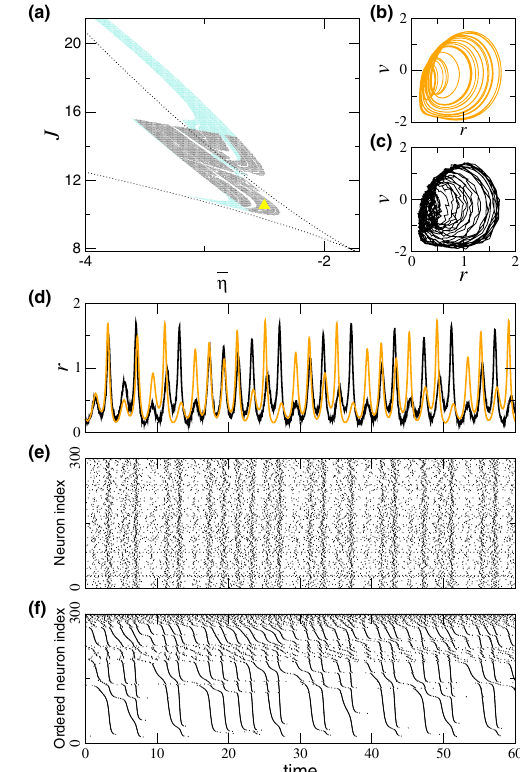
FIG. 3. Firing-rate model predicts the existence of macroscopic chaos in ensemble QIF neurons [Eq. (1)] with an injected periodic current I ð t Þ ¼ I 0 sin ð ω t Þ . (a) Phase diagram with the regions where chaos is found, obtained using the rate model Eq. (12). In the black-shaded region, there is only one chaotic attractor, whereas in the cyan region the chaotic attractor coexists with a periodic attractor. Dotted lines correspond to the bistability boundary of Fig. 1(a), depicted to facilitate comparison. (b) Cha- otic trajectory obtained simulating the FREs (12); the Lyapunov exponent is λ ¼ 0 . 183 … . (c) Chaotic trajectory obtained from the QIF neurons — parameters corresponding to the (yellow) triangle symbol in (a). (d) Time series for the rate model (orange) and QIF model (black). (e) Raster plot corresponding to 300 randomly selected neurons. (f) Same raster plot as in (e), ordering neurons according to their intrinsic current η . Parameters: I 0 ¼ 3 , ω ¼ π k and ¯ η ¼ − 2 . 5 , J ¼ 10 . 5 [triangle symbol in (a)].